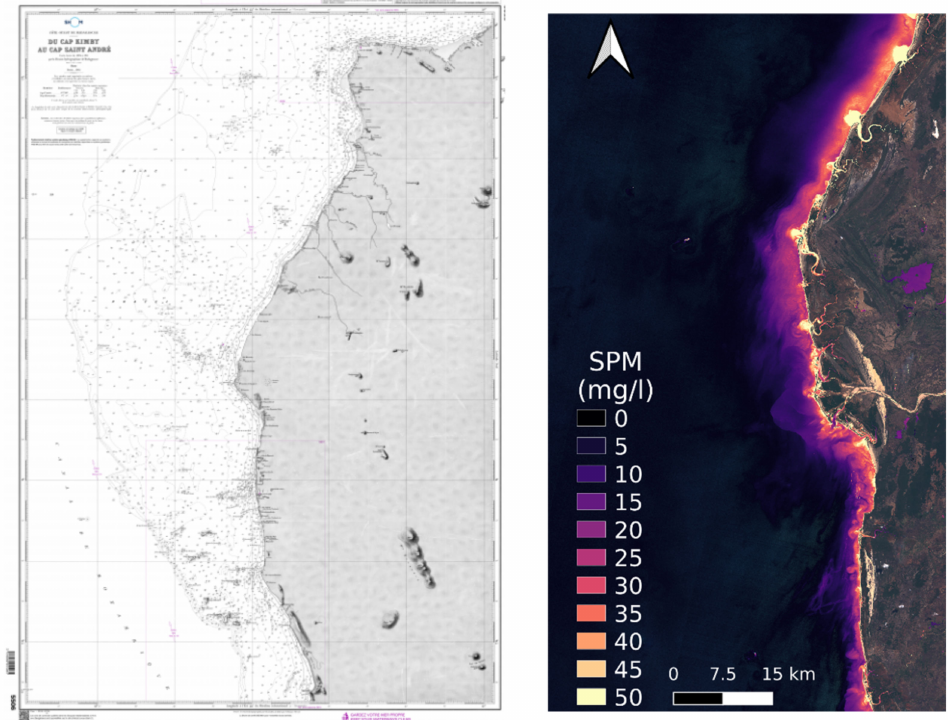
Figure 25. The 3rd Madagascar area of interest. ( a ) Original chart (1915) based on the reconnoitre survey; ( b ) the 3rd AOI’s suspended particular